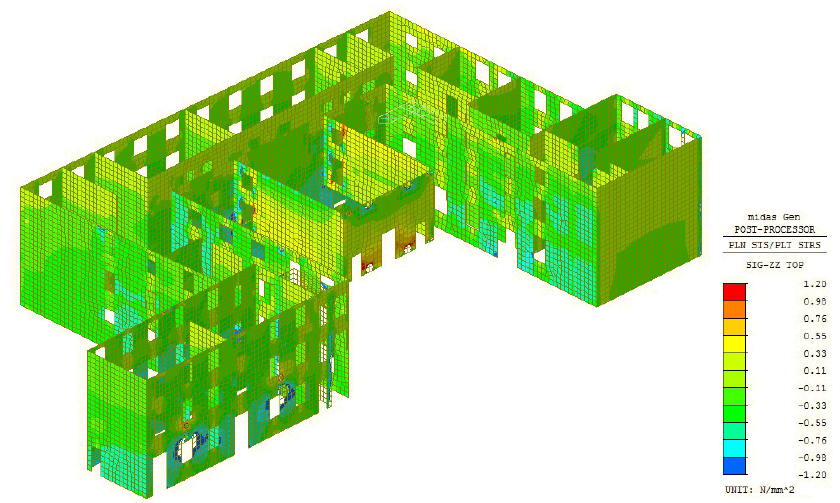
Figure 12. Linear static analysis at the ULS: vertical stress in the